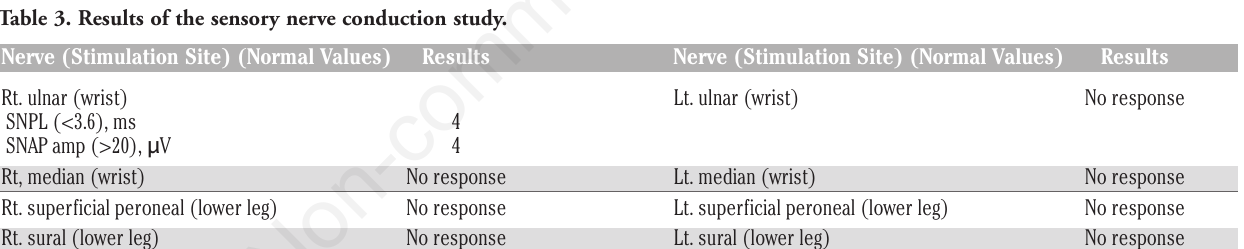
Table 3. Results of the sensory nerve conduction